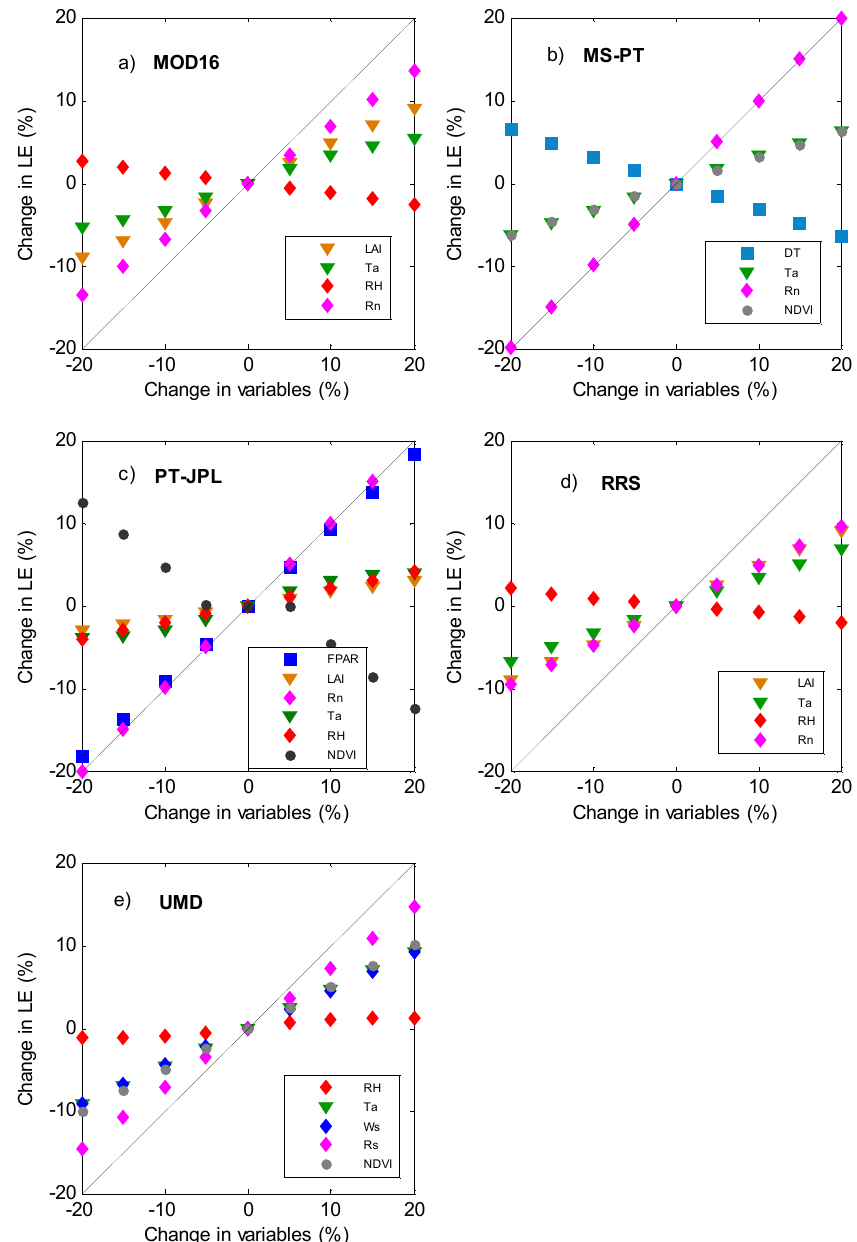
Figure 6. Sensitivity analysis for estimated LE by the ( a ) MOD16; ( b ) MS-PT; ( c ) PT-JPL; ( d ) RRS and ( e ) UMD algorithms with corresponding input variables. The black line is 1:1 line.